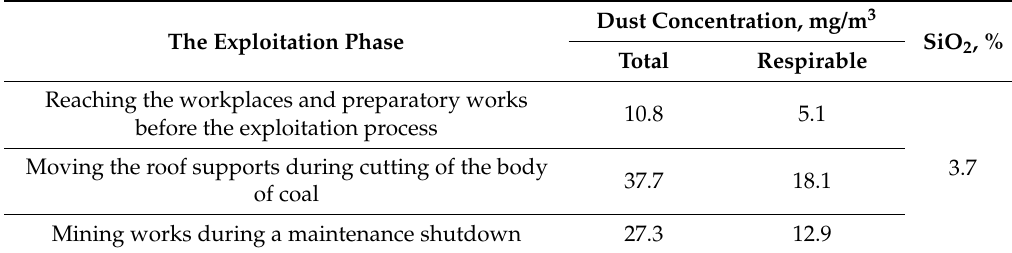
Table 6. The measurement results for the dust levels for selected activities, in the working position the miner working at the junction of the longwall with the tailgate (air outlet).